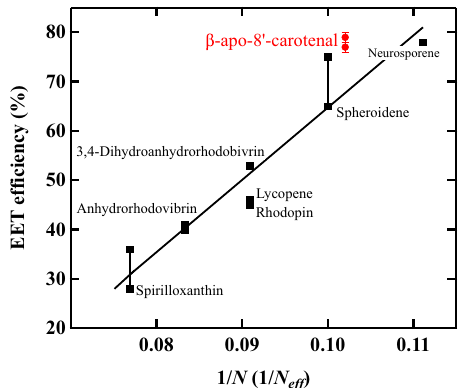
Fig. 8 The relationship between the ef fi ciency of EET from β -apo-8 ′ - carotenal to Bchl a in Re β apo and the effective number of conjugated double bonds. The relationship between the ef fi ciency of EET from β -apo- 8 ′ -carotenal to Bchl a in Re β apo and the inverse of the effective number of conjugated double bonds (1/ N eff ) is overlaid on the plot shown in Fig. 1.